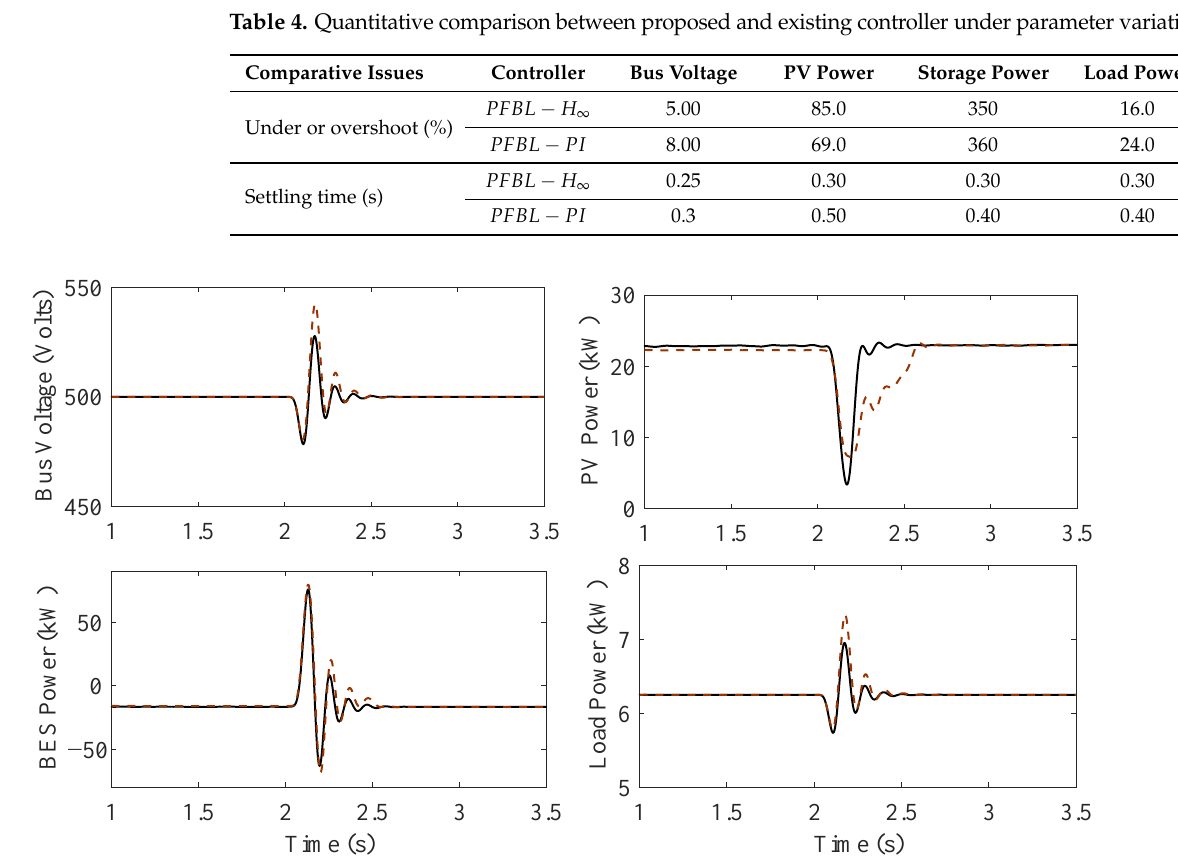
Figure 8. Bus voltage and different power responses under parameter variation.